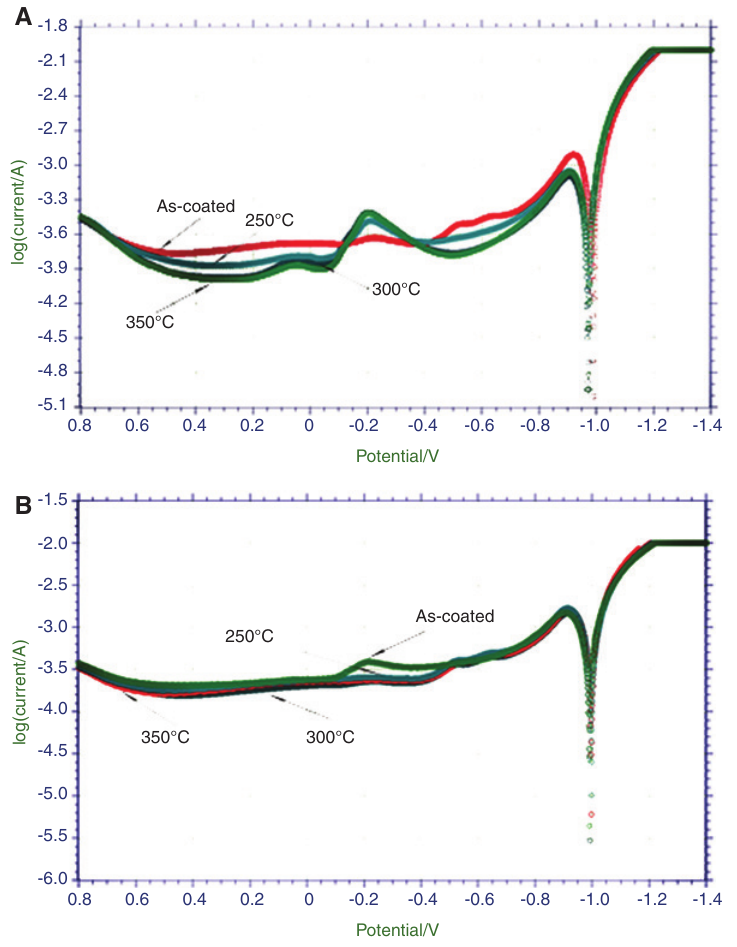
composite coatings in 3.5 wt% NaCl solution. (B) Polarization curves of the 2